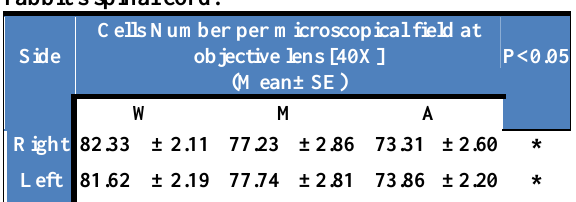
Table, 2: Number of sensory neurons at L7 level of rabbit's spinal cord. Cells Number per microscopical field at